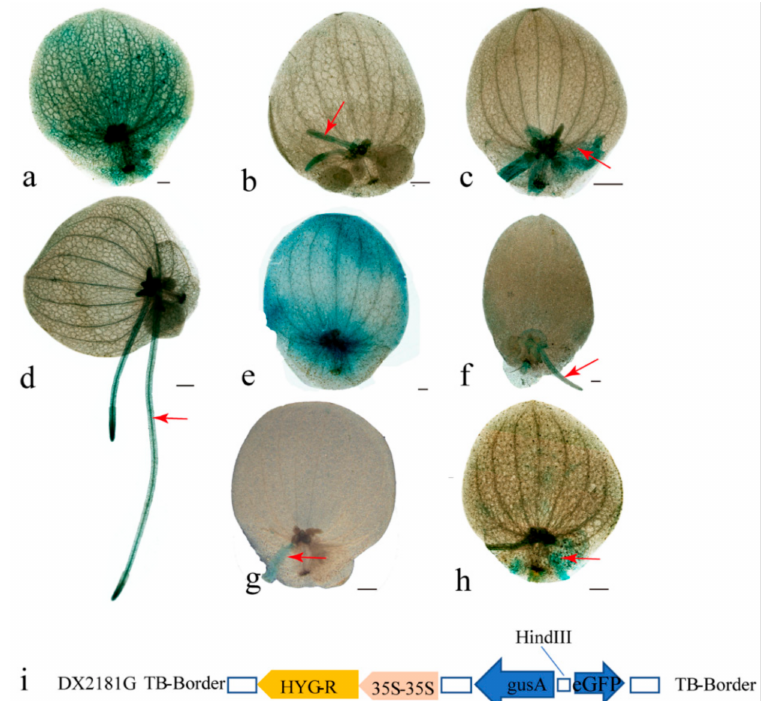
Figure 6. Histochemical analysis of GUS activity and the vector of frame for promoter. GUS staining in each representative transformed line constructed using promoter-GUS. GUS staining of transgenic lines SpNramp1 ( a – c ), SpNramp2 ( d ), ( e ), and SpNramp3 ( f – h ) under 50 µ M Cd 2+ stress. ( a – c ) represent the SpNramp1 that is mainly distributed in frond, root, and joint between mother and daughter frond. ( d , e ) represent the SpNramp2 that is mainly accumulated on the root and frond. ( f – h ) indicate the SpNramp3 that is focused in the root and joint between mother and daughter frond. ( i ). Vector of promoters. SpNramp1 , SpNramp2 , and SpNramp3 are inserted on HindIII